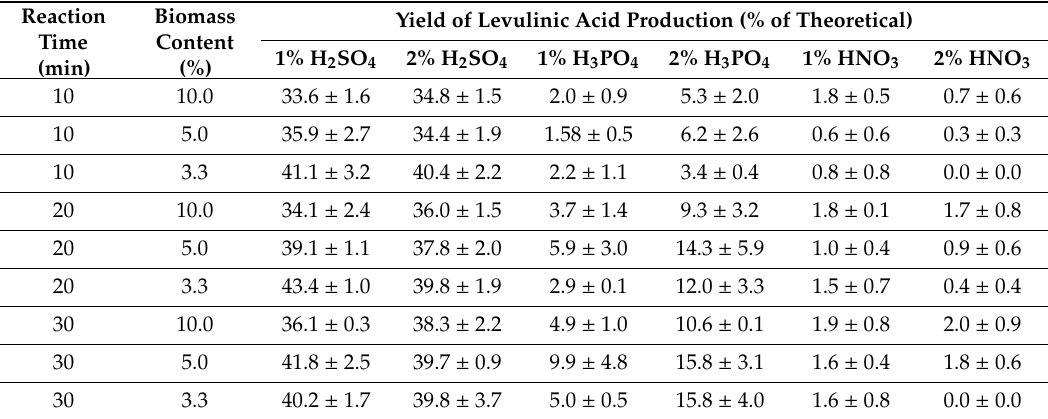
Table 4. Influence of reaction time, biomass content, concentration and type of inorganic acid on the yield of levulinic acid production (based on cellulose content in raw material) from sweet cherry chips.